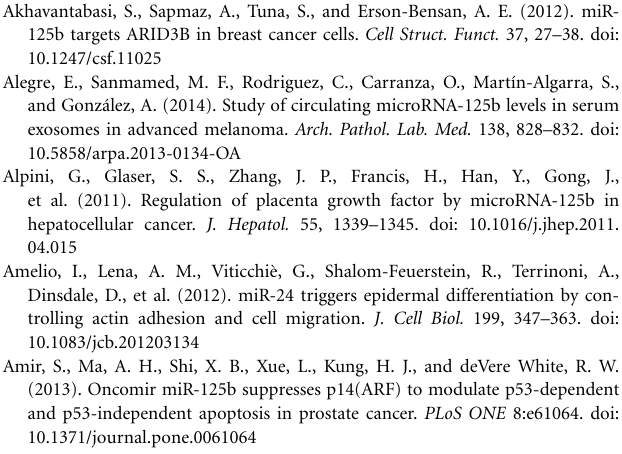
for non-cancerous common diseases (blue box) and major cancers (red box) should be investigated for the establishment of miRNA-based diagnostic